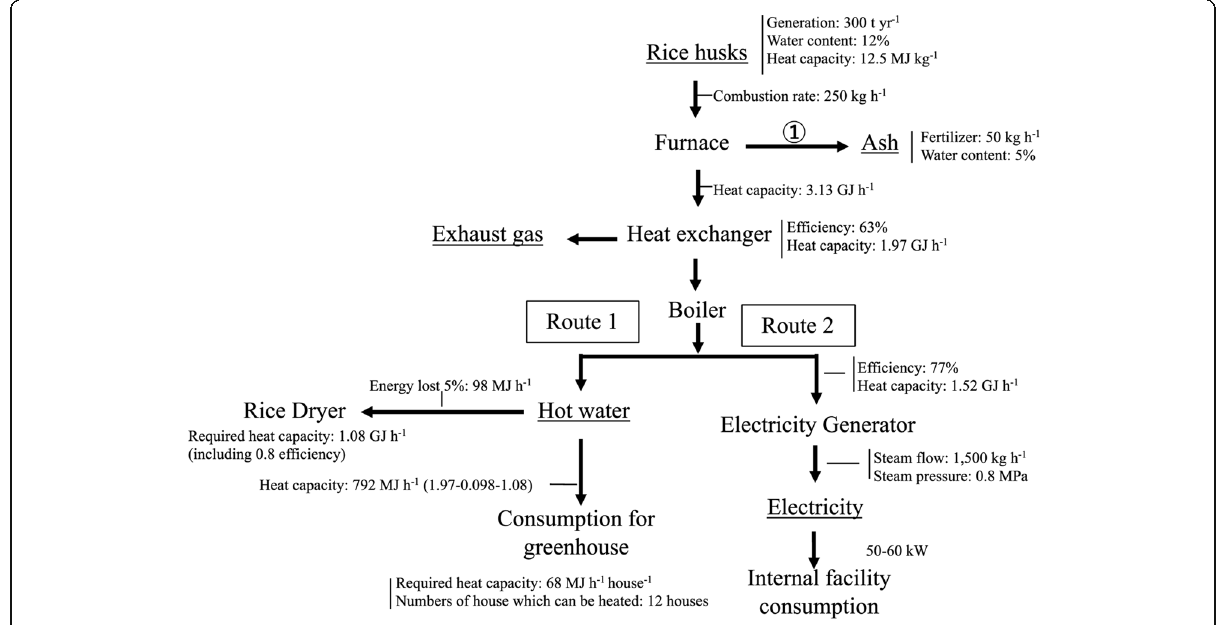
Fig. 7 Two energy recovery schemes based on rice